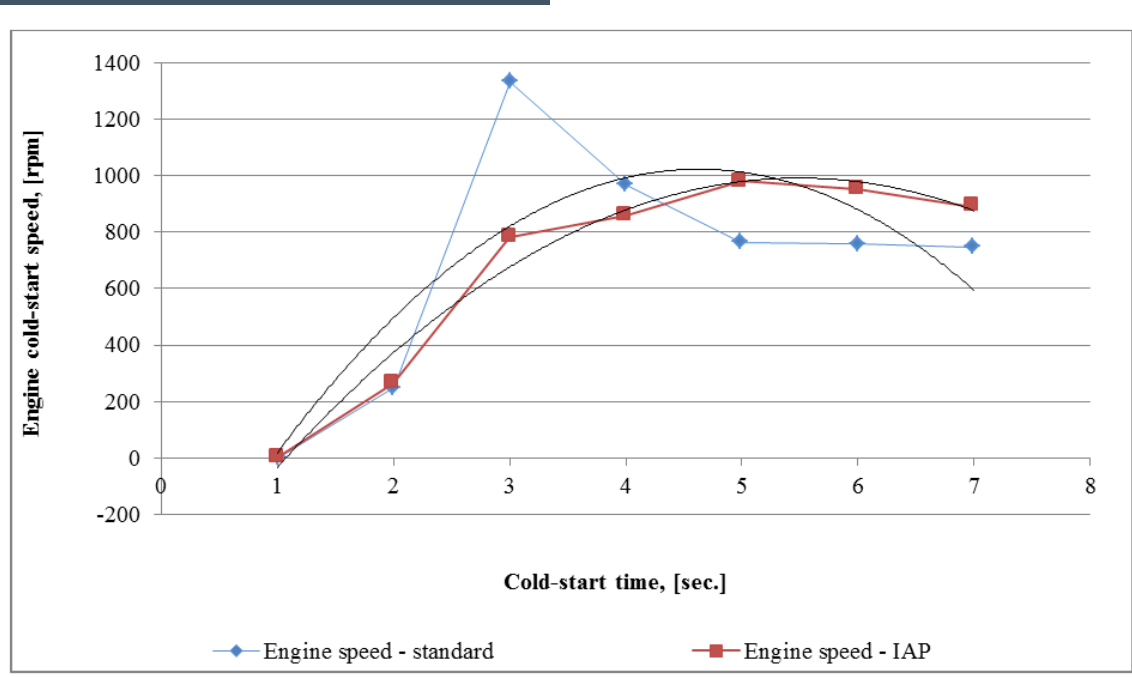
Figure 6. Engine speed during